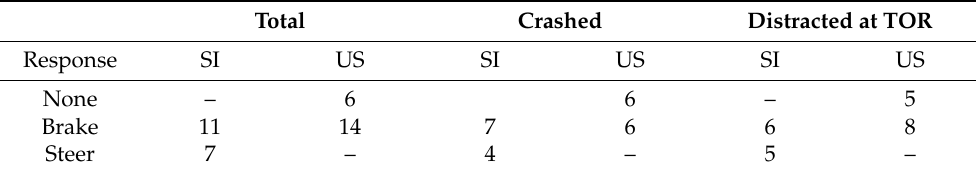
Table 2. Response type and secondary task engagement (IVIS) at TOR, for Slovenia (SI) and USA (US), values = n . Total Crashed Distracted at